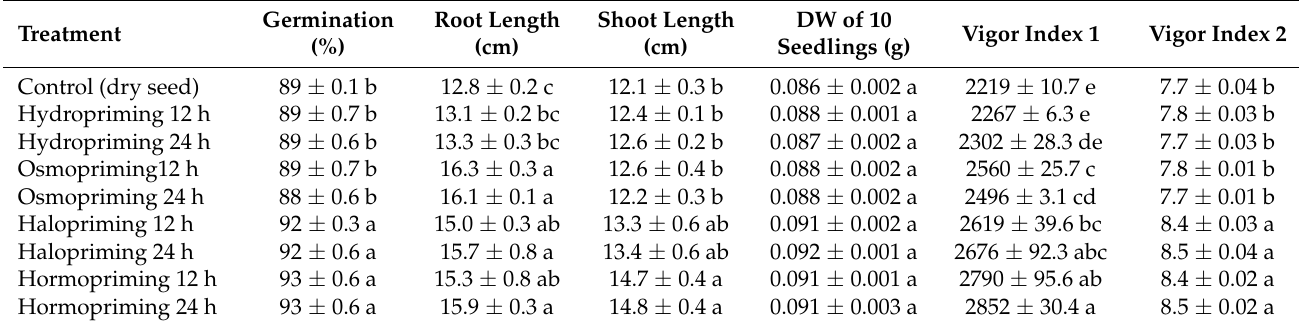
Table 1. Effect of different seed priming techniques on germination, root and shoot length, dry weight (DW) accumulation, and vigor index of paddy seedlings (laboratory studies, average of two runs) 1 .